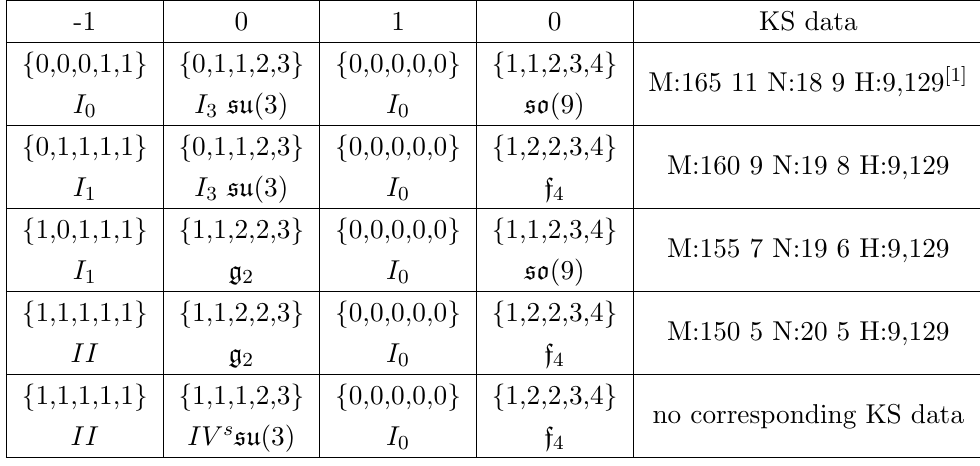
Table 14. Some rank-preserving tunings over the F 1 base. Notice that the Tate vanishing